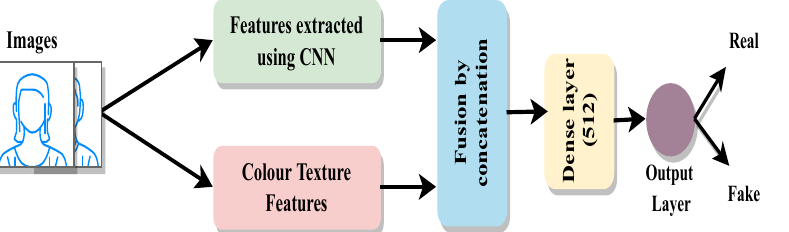
Figure 4. Fusion Method: In total, 4 different models were built, one for each of the pre-trained deep neural networks plus a custom CNN trained on each respective dataset. In each model, the extracted deep features were concatenated with colour texture features and then passed to the classifier for PA detection. The classifier consisted of a fully connected layer of size 512 and a sigmoid layer.